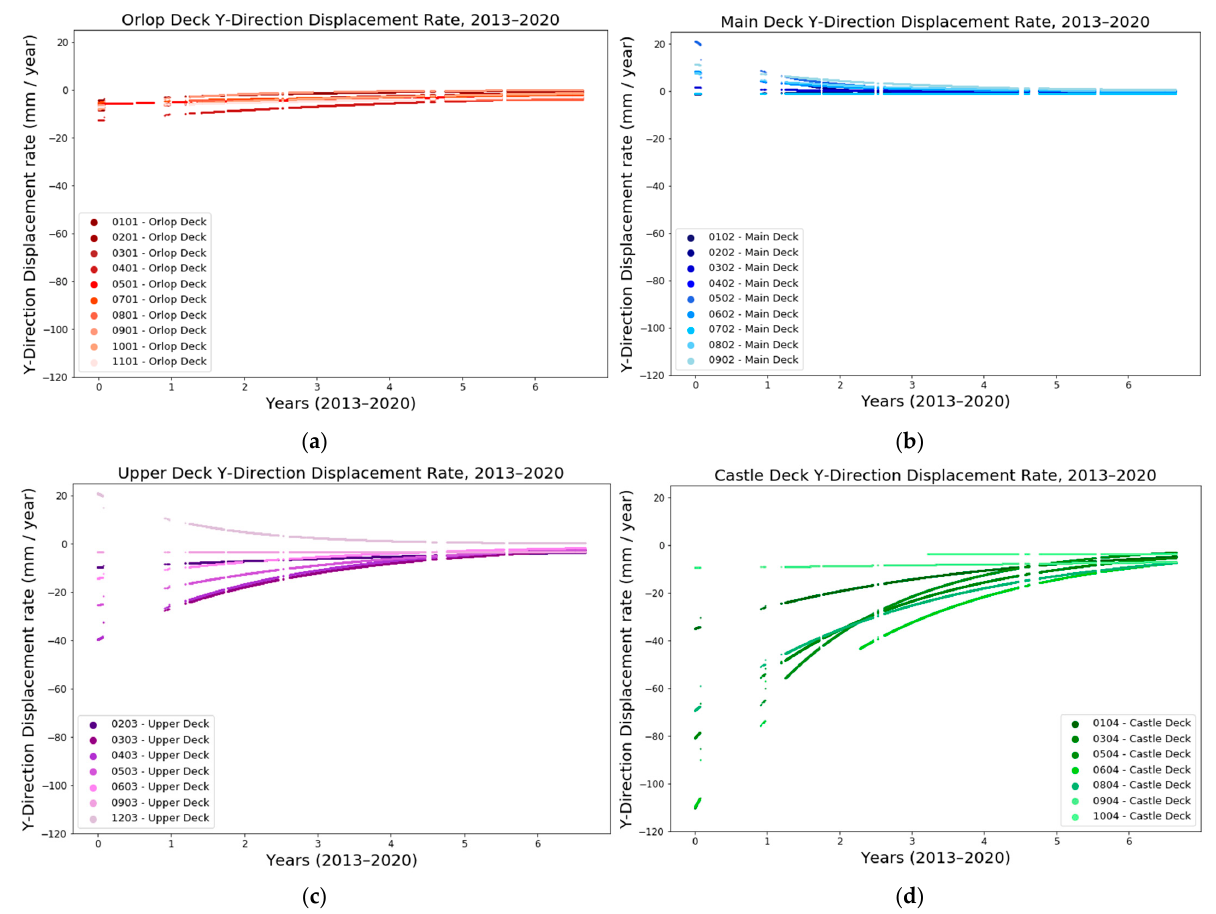
Figure 7. Rate of the Y displacement of the TS targets in the ( a ) orlop, ( b ) main, ( c ) upper and ( d ) castle decks plotted against time for the period between September 2013 and March 2020.